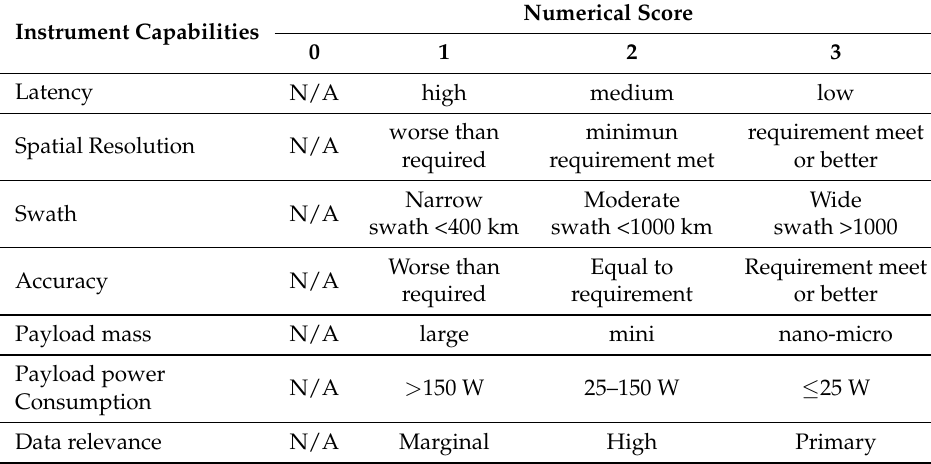
Table 10. Instrument technologies’ attributes and related numerical